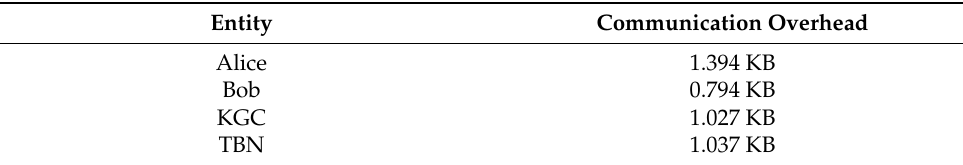
Table 6. Communication overhead of each entity.